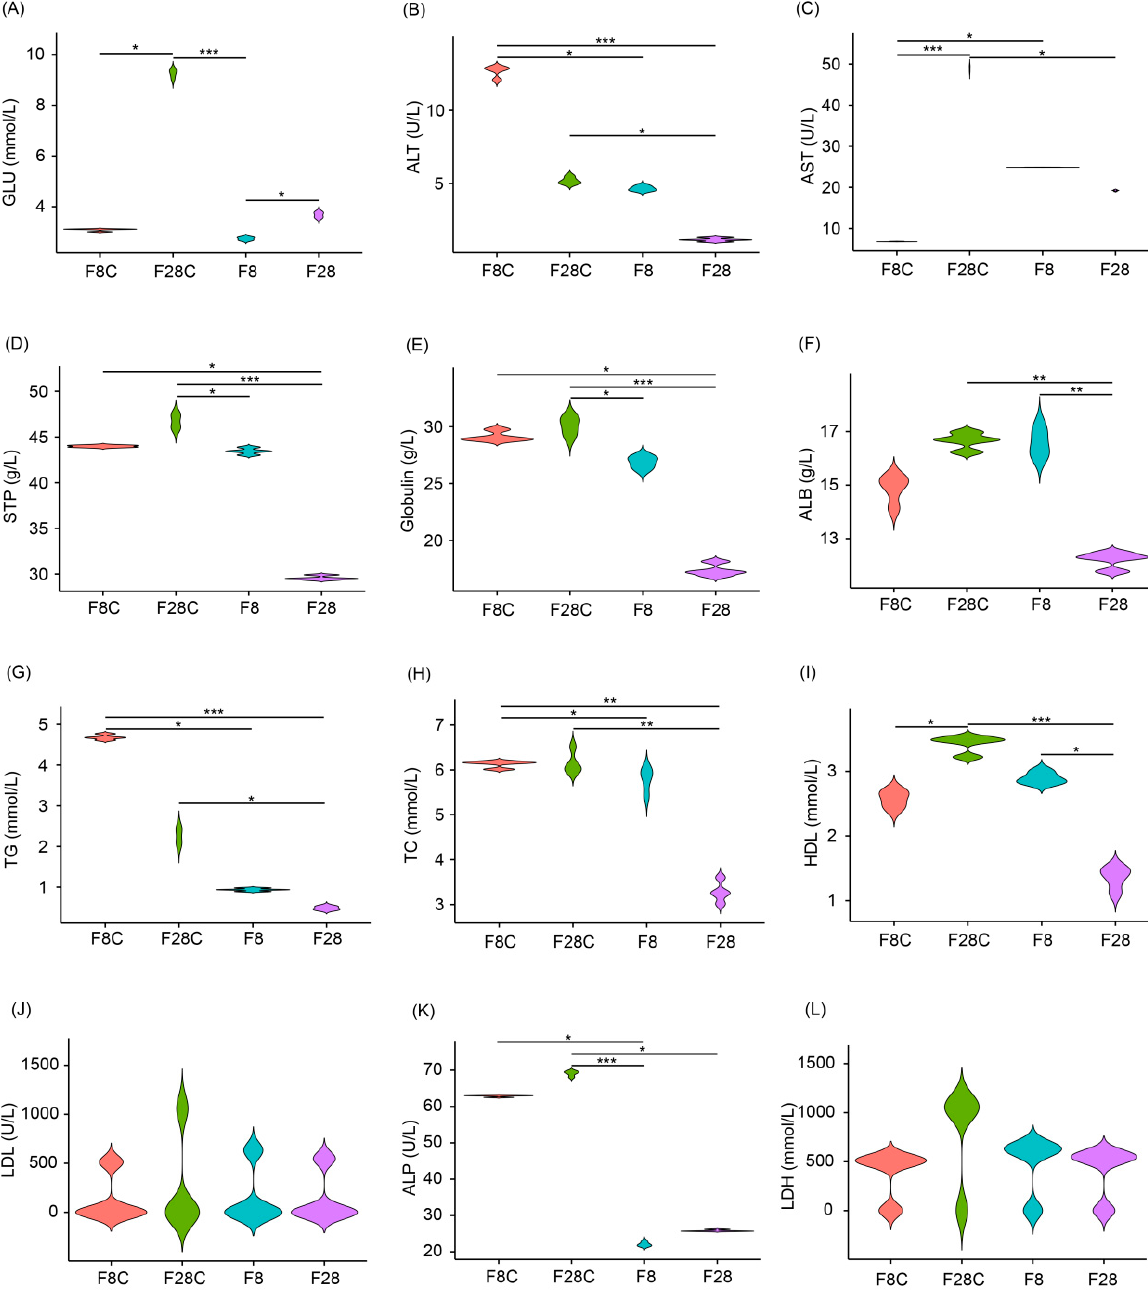
Figure 2. E ff ects of starvation on serum indices of yellowcheek. ( A ) Serum glucose (GLU), ( B ) ala- Figure 2. Effects of starvation on serum indices of yellowcheek. ( A ) Serum glucose nine aminotransferase (ALT), ( C ) aspartate aminotransferase (AST), ( D ) serum total protein (STP), ( E ) globulin, ( F ) albumin (ALB), ( G ) triglyceride (TG), ( H ) total cholesterol (TC), ( I ) high-density lipoproteins (HDL), ( J ) low-density lipoproteins (LDL), ( K ) alkaline phosphatase (ALP), and ( L ) lactate dehydrogenase (LDH). F8C: un-starved yellowcheek samples collected on the 8th day after the starvation experiment; F28C: un-starved yellowcheek samples collected on the 28th day after the starvation experiment; F8: starved yellowcheek samples collected on the 8th day after the star-